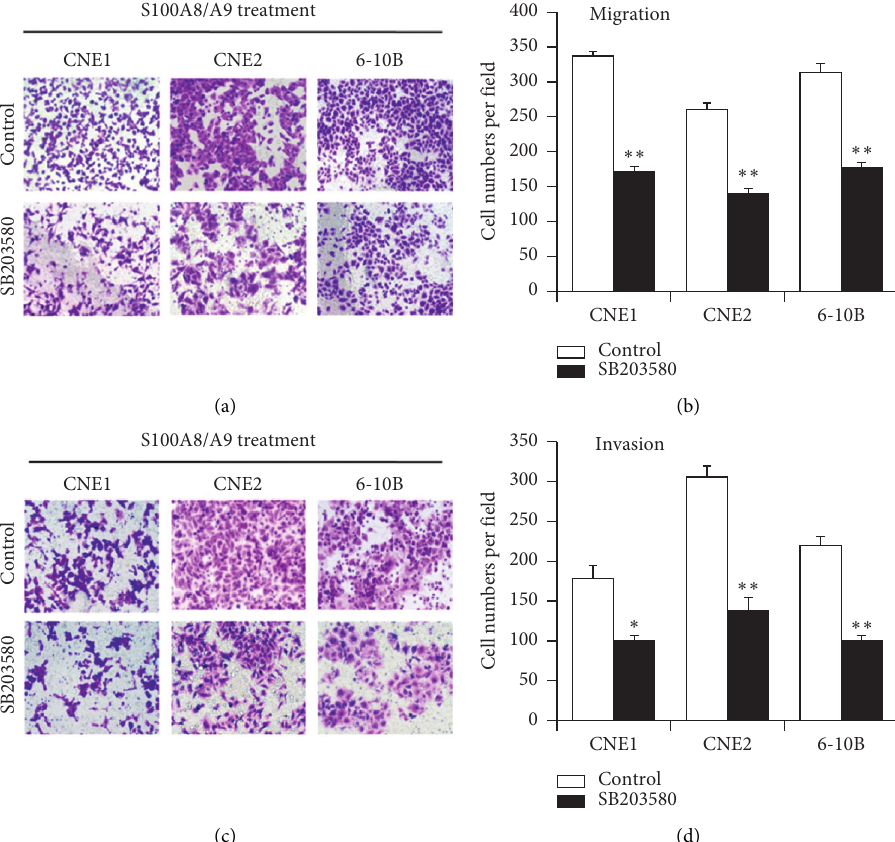
Figure 3: Effects of exogenous S100A8/A9 stimulation on the p38 MAPK pathway in NPC cells. (a) Representative images for the effects of S100A8/A9 proteins on migration of NPC cells after p38 MAPK inhibitor pretreatment (magnification 200 × ). (b) Quantifications of S100A8/A9 protein effects on migration of NPC cells after p38 MAPK inhibitor pretreatment. n � 3, ∗∗ P < 0 . 01. (c) Representative images for the effects of S100A8/A9 proteins on invasion of NPC cells after p38 MAPK inhibitor pretreatment (magnification 200 × ). (d) Quanti- fications of S100A8/A9 protein effects on invasion of NPC cells after p38 MAPK inhibitor pretreatment. n � 3, ∗ P < 0 . 05 and ∗∗ P < 0 . 01.